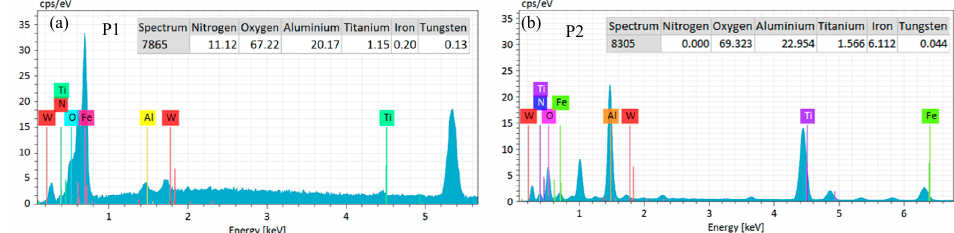
Figure 15. ( a ) EDS analysis point P1 of Tool A in Figure 13. ( b ) EDS analysis point P2 of Tool A in Figure 13.